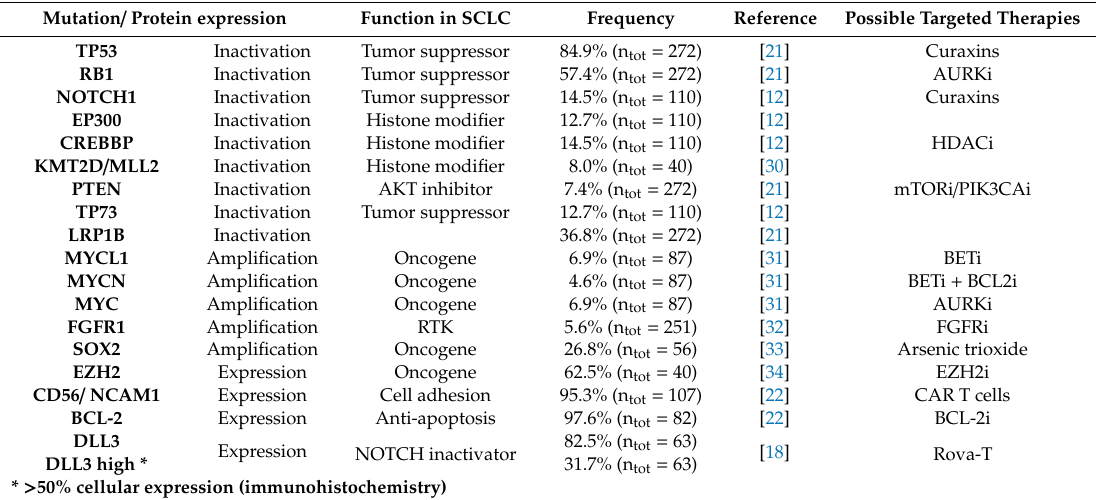
Table 1. Frequent mutations and protein expression patterns in small cell lung cancer